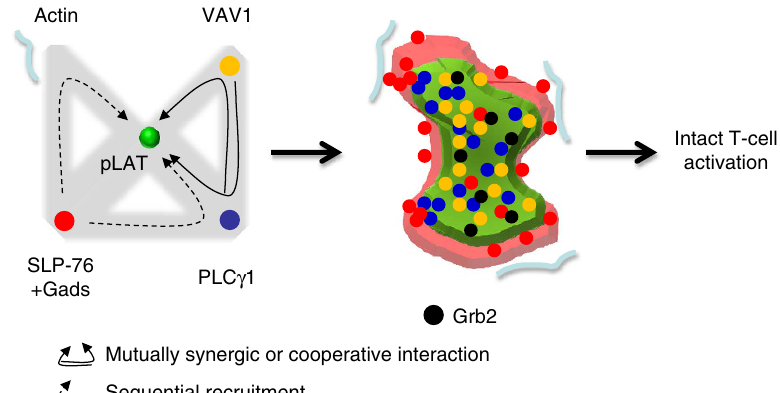
Figure 6 | A model of sequential and hierarchical recruitment of effectors to LAT clusters. A model that summarizes the set of hierarchical molecular interactions (left) that lead to the hierarchical structure (right) of LAT-nucleated clusters and intact T-cell activation. PLC g 1 and VAV1 show mutual interaction synergy, interpreted here as cooperativity, in their recruitment to LAT clusters. SLP-76 molecules in proximity to PLC g 1 or actin showed enhanced proximity to LATmolecules, but proximity to SLP-76 did not increase the recruitment of PLC g 1 or VAV to LAT. The clusters are ordered such that VAV1 molecules are closest to LAT in the centre of the cluster, PLC g 1 molecules are the next closest, with most SLP-76 and actin molecules around the